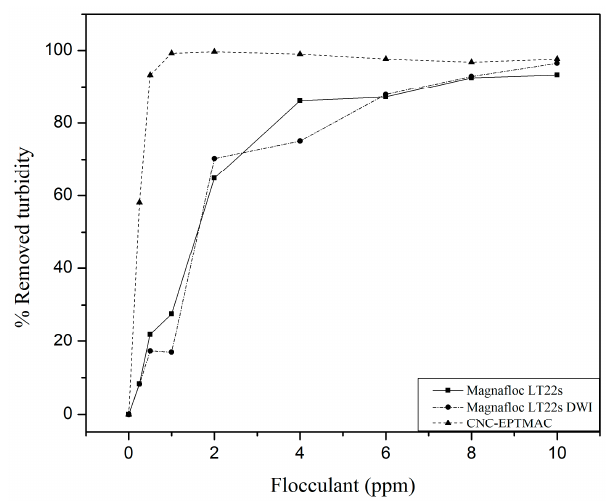
Figure 10. CNC-EPTMAC flocculation efficacy as compared to commercial flocculants.